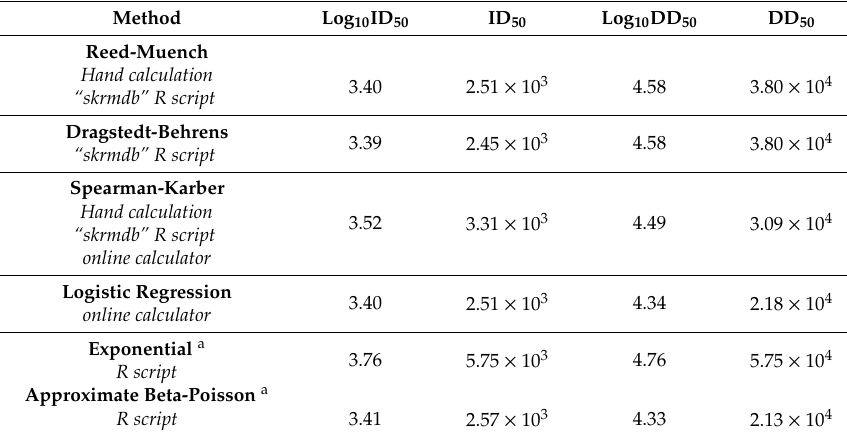
Table 2. ID 50 and DD 50 calculations of Cin-2.